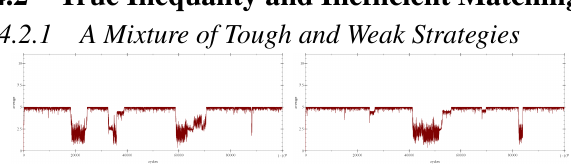
Figure 7: Periods with population mean very